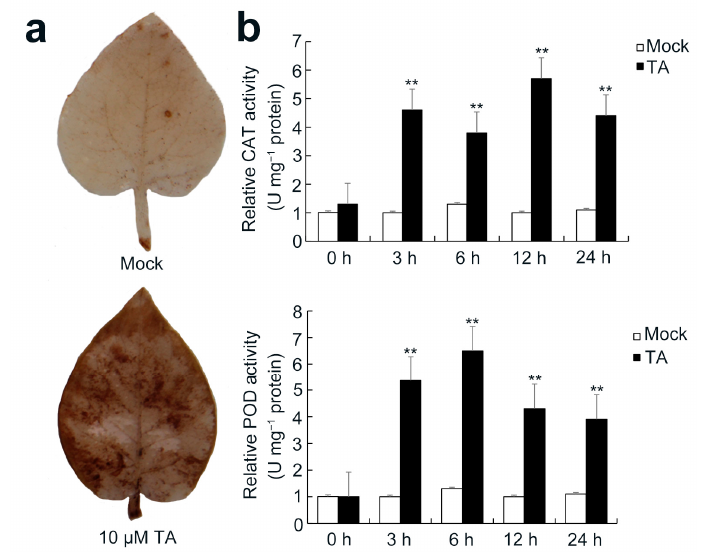
Figure 9. Analyses of 3,3 ′ -diaminobenzidine (DAB) stain and reactive oxygen species (ROS)-related enzymatic activities in TA leaves. ( a ) DAB stain to detect the hydrogen peroxide (H 2 O 2) accumulation in leaves; 4-week-old potato leaves were treated with ddH 2 O or 10 µ M TA. ( b ) ROS-related peroxidase (POD) and catalase (CAT) activities in leaves. All experiments were performed in triplicate. The asterisks indicate statistically significant differences, as determined by a Student’s t -test (** p < 0.01).